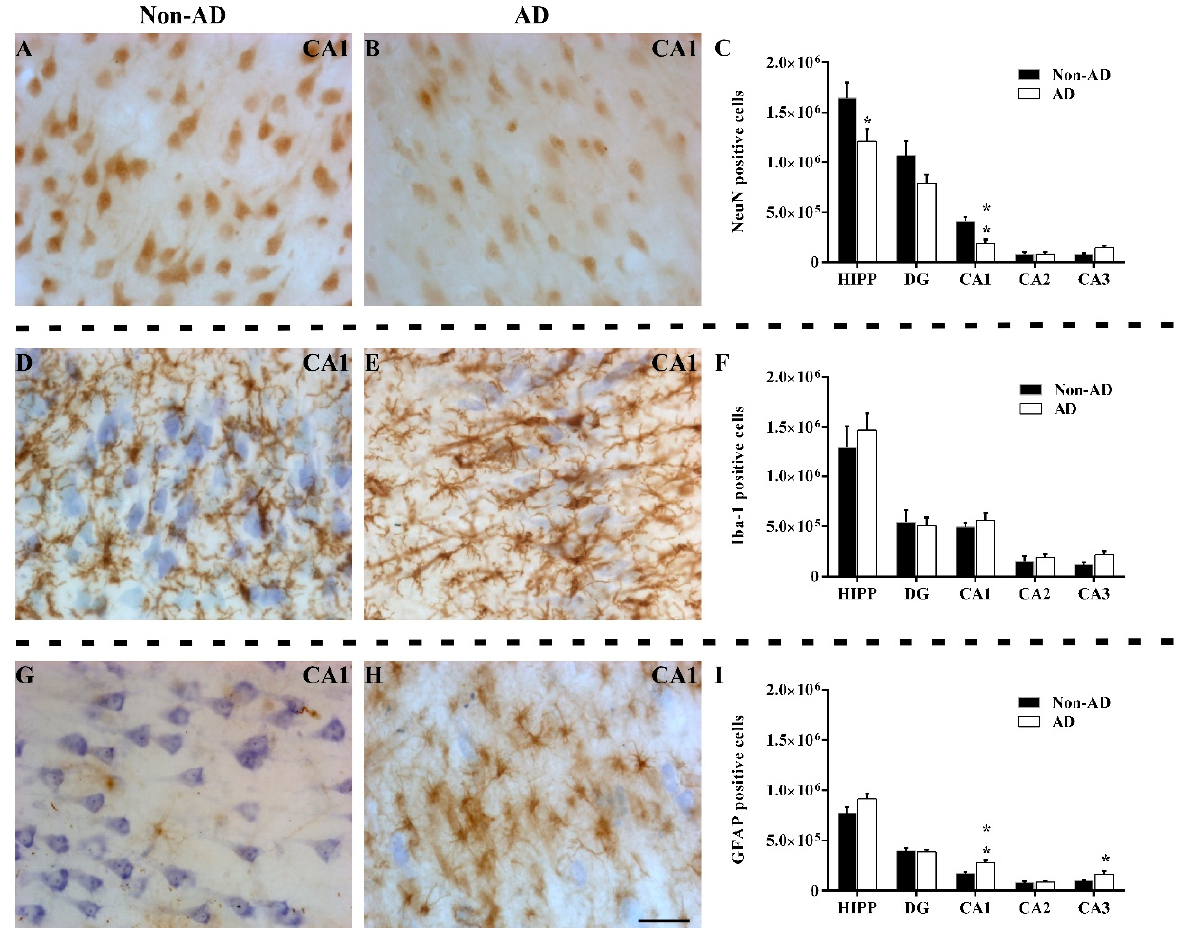
Figure 2. The extent of neurodegeneration, microgliosis, and astrogliosis differs among hippocampal fields. Immunohistochemical staining for NeuN ( A,B ), Iba-1 ( D,E ), and GFAP ( G,H ) in the CA1 subfield in non-AD and AD samples represent neurons, microglia, and astroglia, respectively. The number of NeuN-positive cells ( C ), Iba-1 positive cells ( F ) and GFAP-positive cells ( I ) in the global HIPP and the different subfields are shown (the graphs show the mean ± SEM, * p value < 0.05, ** p value < 0.01). Please note that neurodegeneration linked to NeuN labeling only occurred in the CA1 region, staining of microglia with Iba-1 was not altered, and GFAP staining of astroglia was increased in both CA1 and CA3. Scale bar = 50 µm.